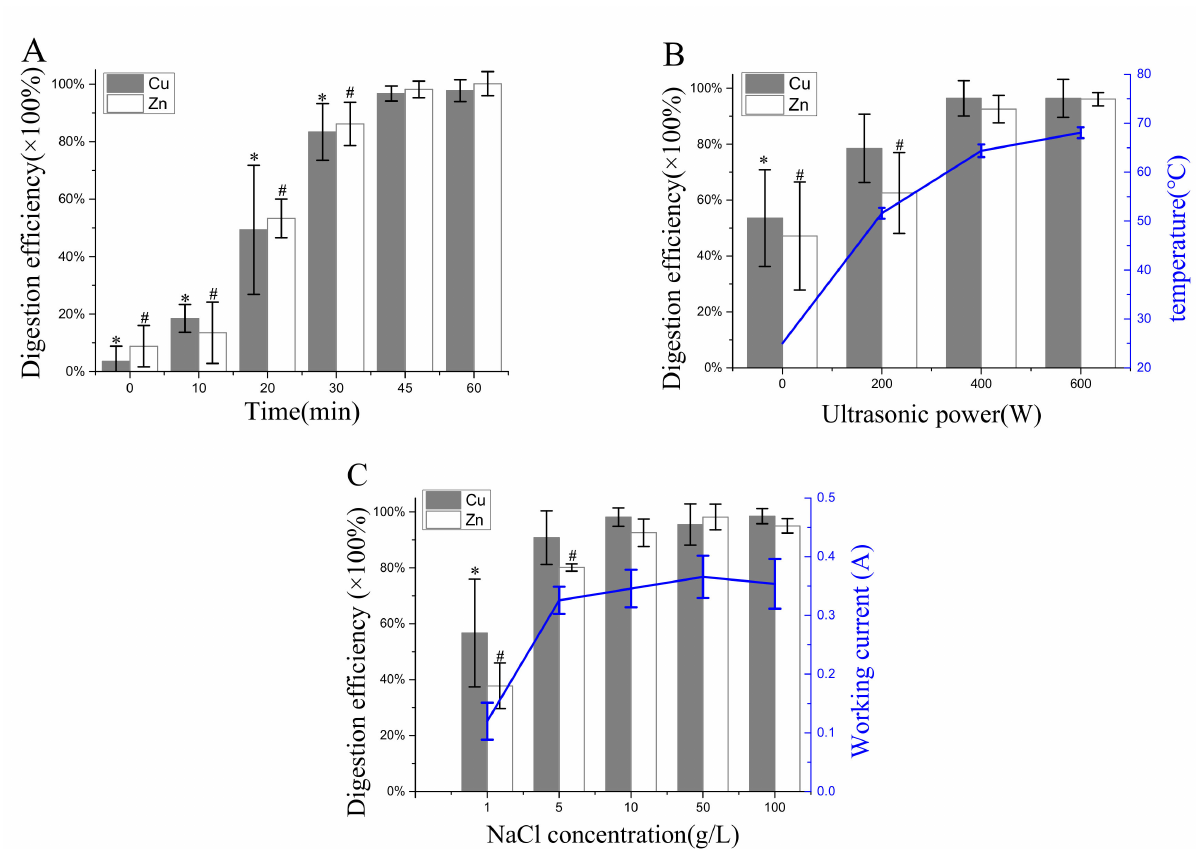
Figure 3. Variations in Cu and Zn digestion efficiency, solution temperature, and working current during UAEO digestion method. ( A ) Cu and Zn digestion efficiency was tested for different periods at 400 W ultrasonic power with a NaCl concentration of 10 g/L. Significant differences between each digestion time and 60 min group were found with the Dunnet’s test; * p < 0.05 for Cu, # p < 0.05 for Zn. ( B ) Digestion efficiency was tested at 0, 200, 400, and 600 W ultrasonic power for 45 min with a NaCl concentration of 10 g/L, and the solute temperature was detected. Significant differences between each ultrasonic power and 600 W group were found with the Dunnet’s test; * p < 0.05 for Cu, # p < 0.05 for Zn. ( C ) Digestion efficiency was tested with NaCl concentrations of 1, 5, 10, 50, and 100 g/L at 400 W ultrasonic power for 45 min, and the working current was tested using an electronic working station. Significant differences between each NaCl concentration and 100 g/L group were found with Dunnet’s test; * p < 0.05 for Cu, # p < 0.05 for Zn.